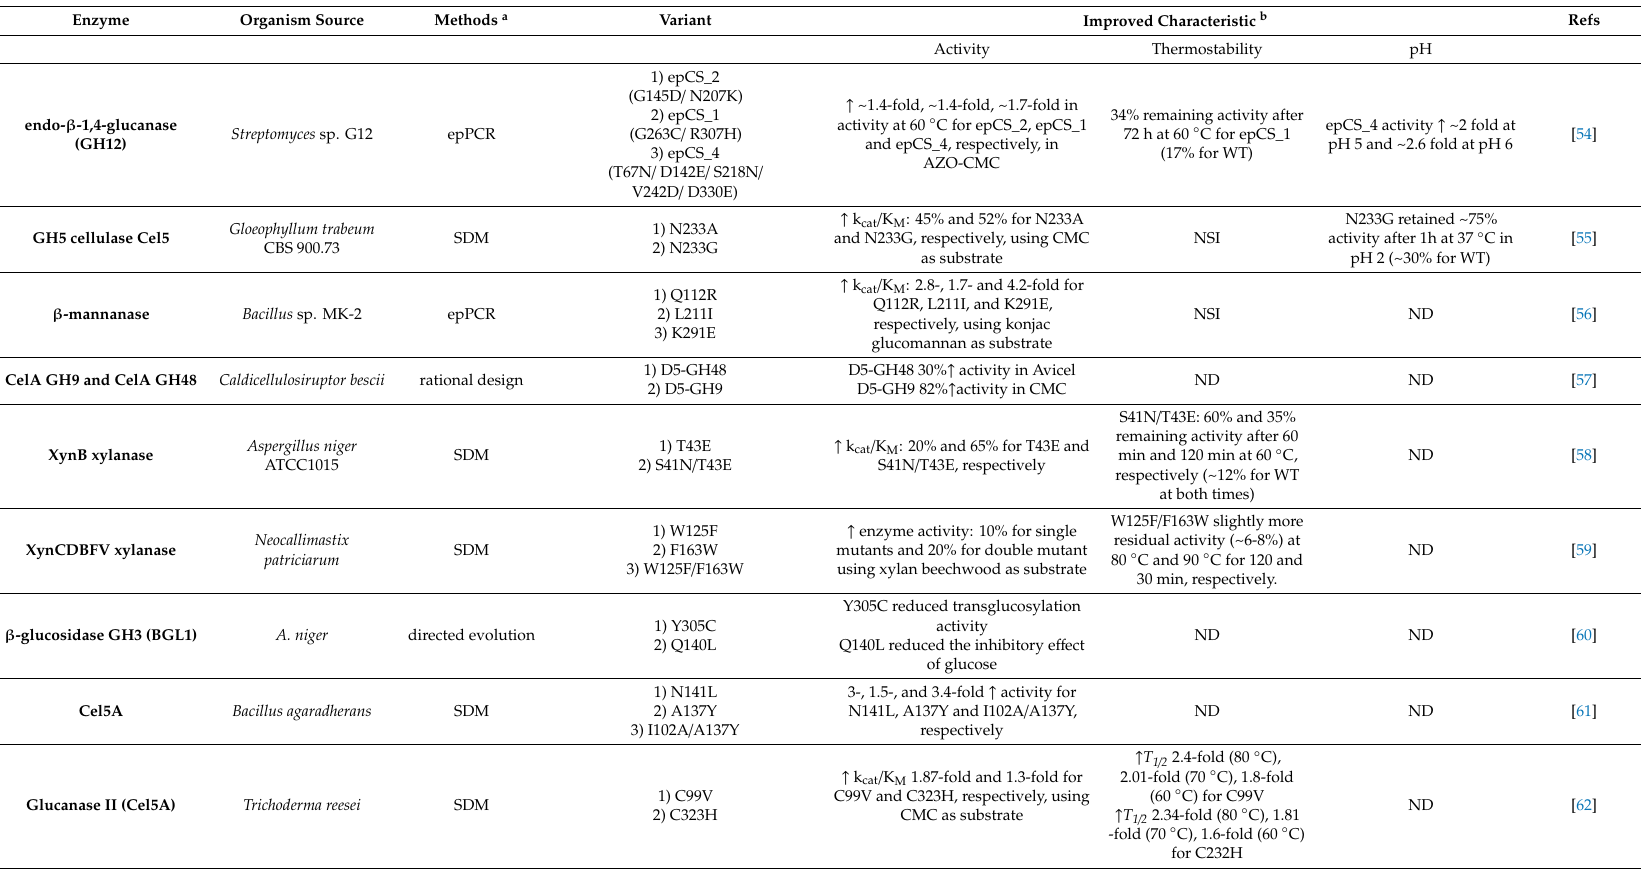
Table 2. Recent progress in engineered biomass-converting